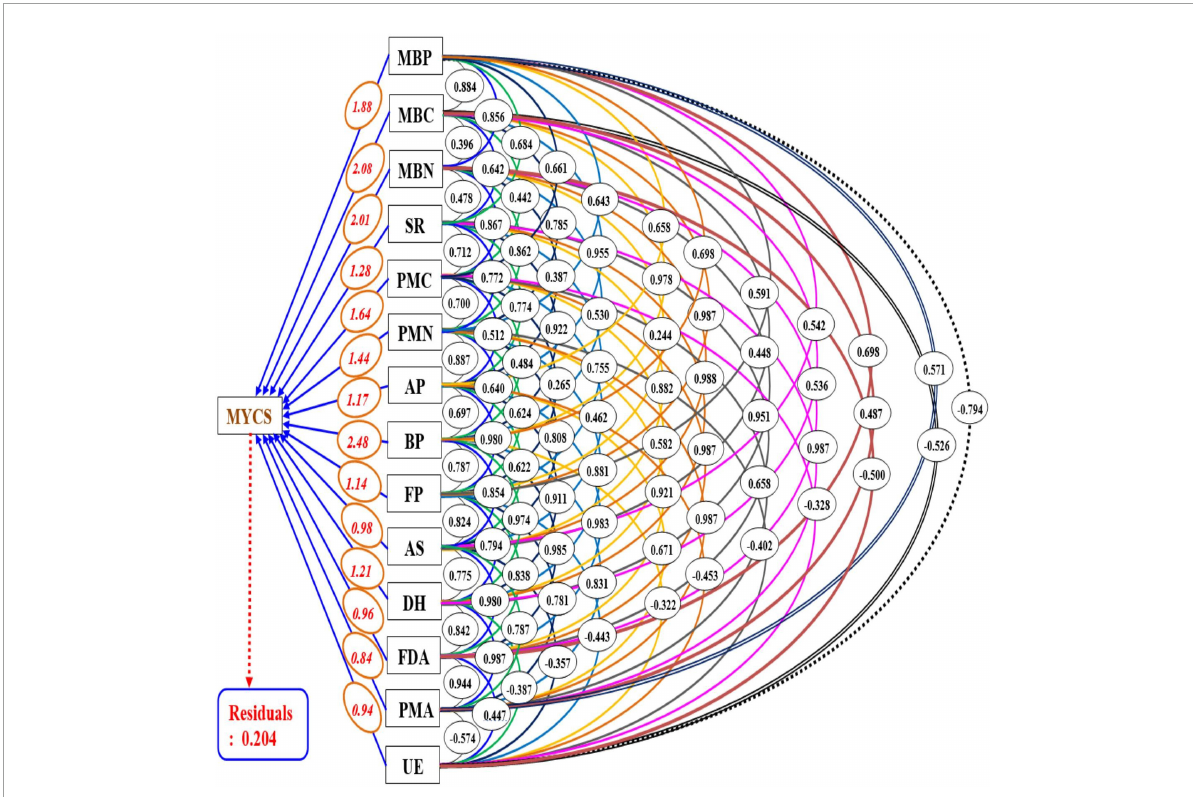
FIGURE6 Path diagram depicting the contribution of soil biological entities to the MYCS in cauliflower-cowpea–okra cropping system. Single-headed arrows, double-headed arrows and connectors signify the path coefficient ( β ) (direct effect), simple correlation coefficients between variables and mutual association, respectively; where, MYCS, mean yield of the cropping system; MBC, microbial biomass carbon; MBN, microbial biomass nitrogen; SR, soil respiration; PMC, potentially mineralizable carbon; PMN, potentially mineralizable nitrogen; AP, total actinomycetes population; BP, total bacterial population; FP, total fungal population; AS, arylsulphatase activity; DH, dehydrogenase activity; FDA, fluorescein di-acetate hydrolysis; PMA, phosphomonoesterase activity; UE, urease